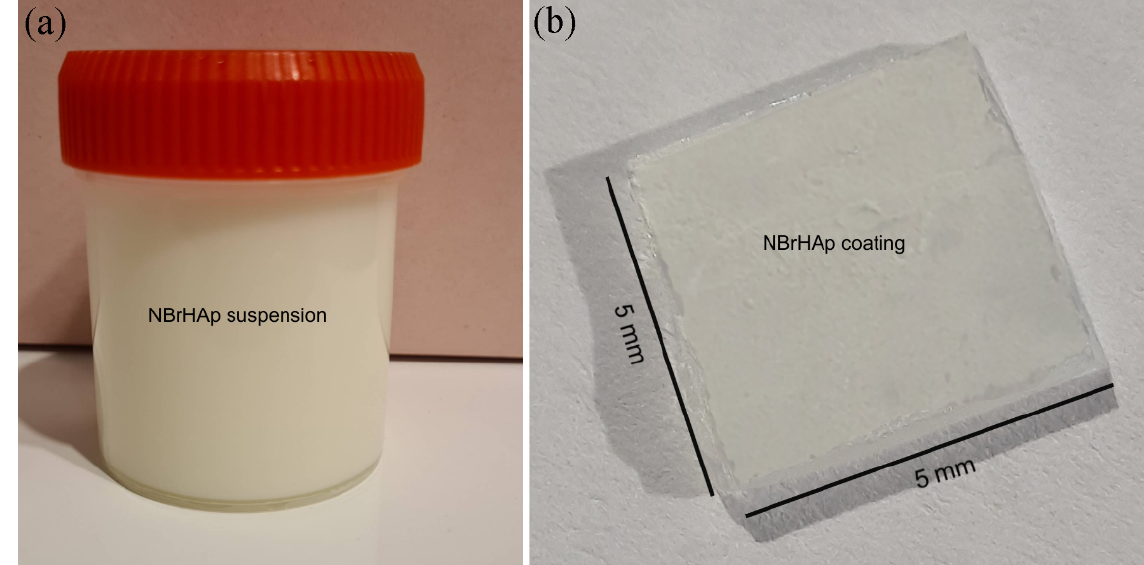
Figure 1. Images of the obtained NBrHAp suspension ( a ), and composite coatings ( b ).